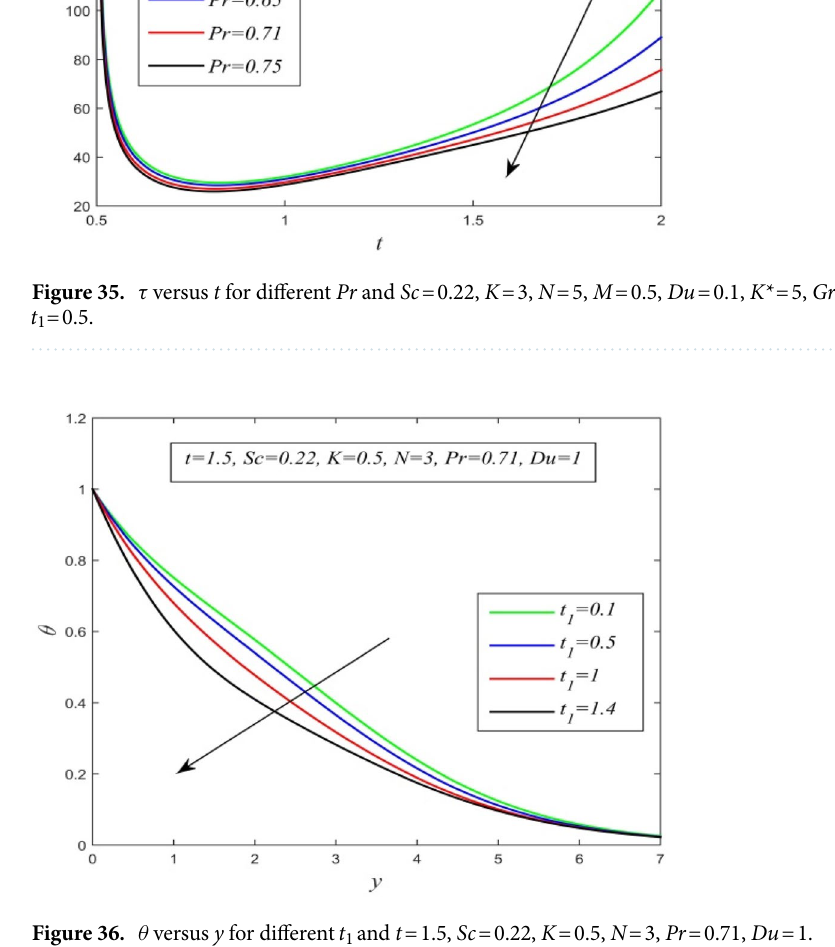
Figure 36. θ versus y for different t 1 and t = 1.5, Sc = 0.22, K = 0.5, N = 3, Pr = 0.71, Du =